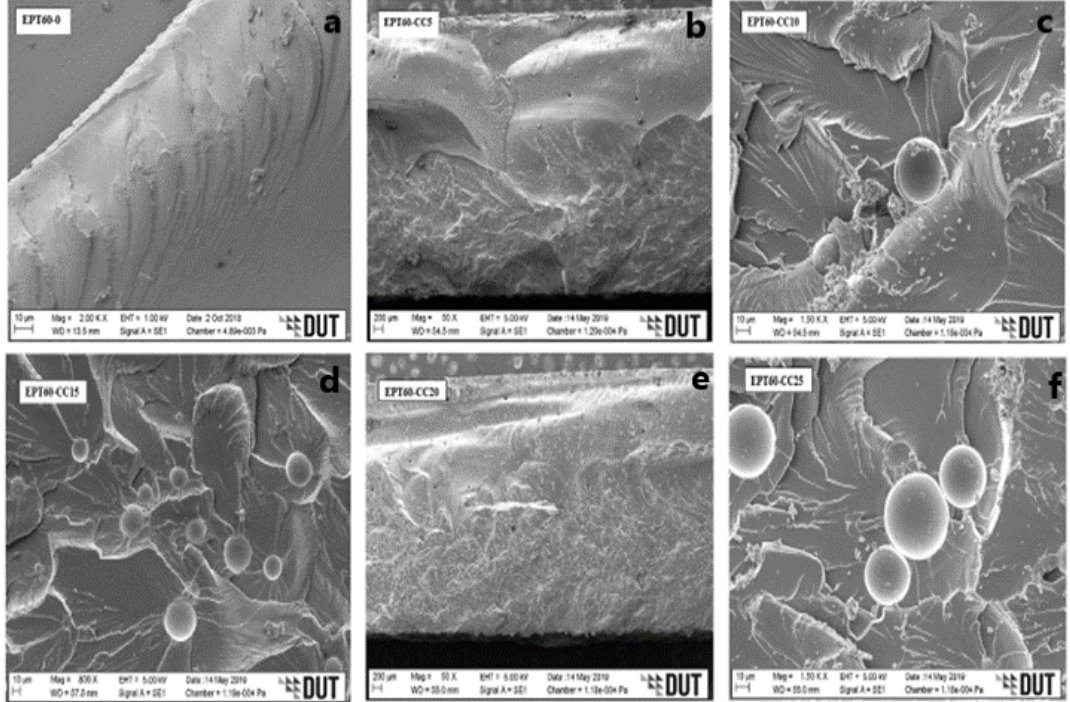
Figure 6. SEM images for flexural fractured specimens of SFC-homogenous HGM at ( a )